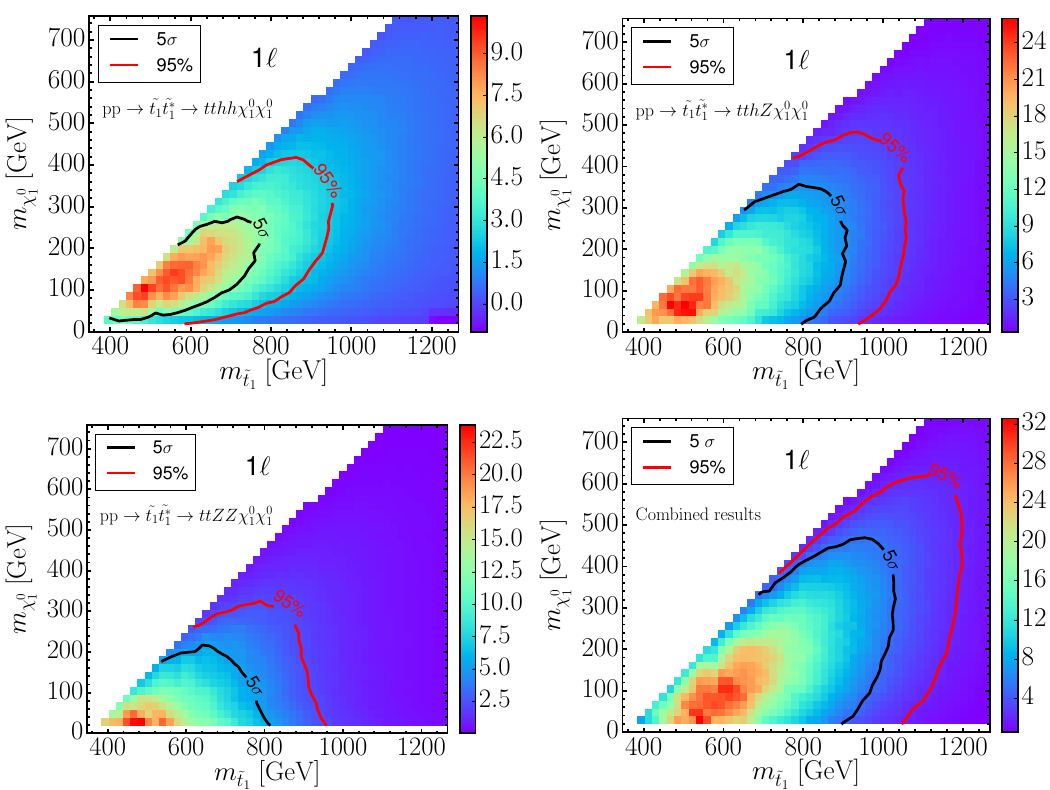
Figure 4 . The 95% C.L. upper limits (black) and 5 (cid:27) discovery reach (red) are shown in the plane of MSSM parameter space m ~ vs m for the stop pair production pp (cid:31) 0 1 t 1 E E (top left), t (cid:22) thZ (top right), t (cid:22) tZZ (bottom left), combined channels (bottom right) for the T T 6 6 1 ‘ signal region at the 14 TeV LHC with 300 fb (cid:0) 1 integrated luminosity. (cid:22) is (cid:12)xed to be M 1 + 150 GeV. 10% systematic error has been included in the analyses. The color coding on the right indicates the signal signi(cid:12)cance to guide the eye.